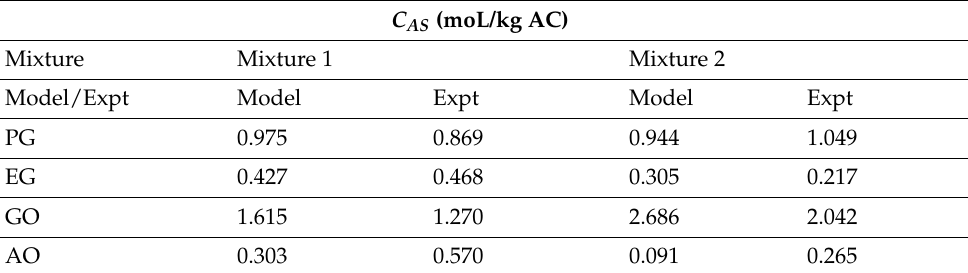
Table 6. Predicted results by Langmuir’s multicomponent adsorption model and experimental ones for the two mixtures. C AS (moL/kg